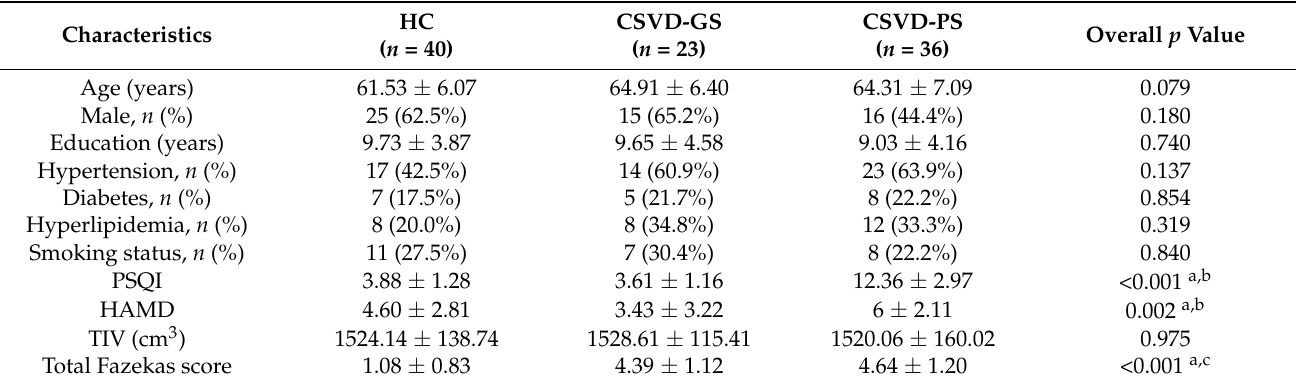
Table 1. Demographic and clinical